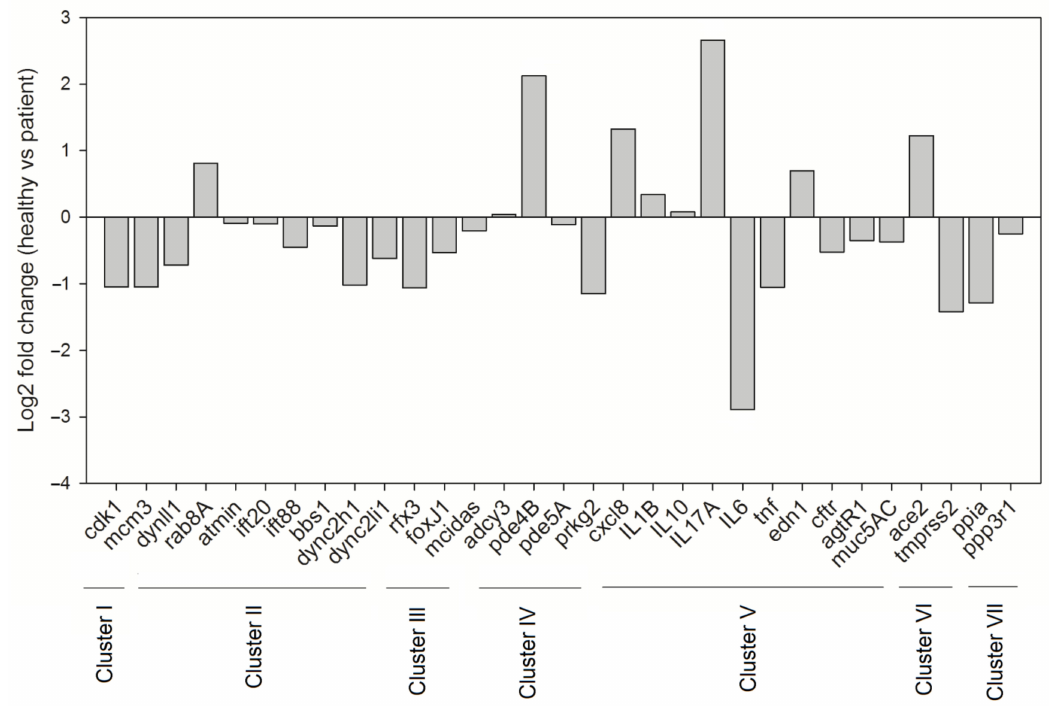
Figure 5. Differential expression (log2 fold change) of mucociliary clearance related gene transcripts in SARS-CoV-2-infected patients relative to healthy individuals. Clusters I–V represent genes associated with cell cycle regulation, IFT machinery, cilia biogenesis and regulation, cAMP regulation, and immune defense, respectively, whereas cluster VI and VII represent genes controlling SARS-CoV-2 entry and infection,